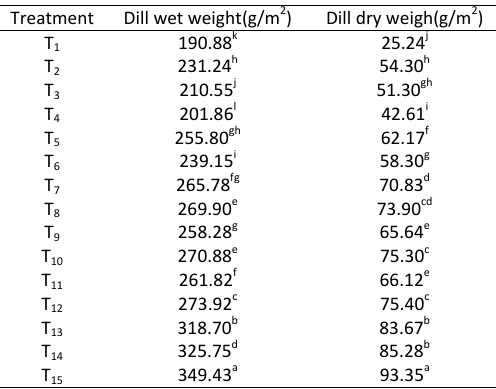
Table 6: Comparison of means of soil bulk density and void ratio under different Table 6. Comparison of means of soil bulk density and void ratio treatments under different treatments Treatment